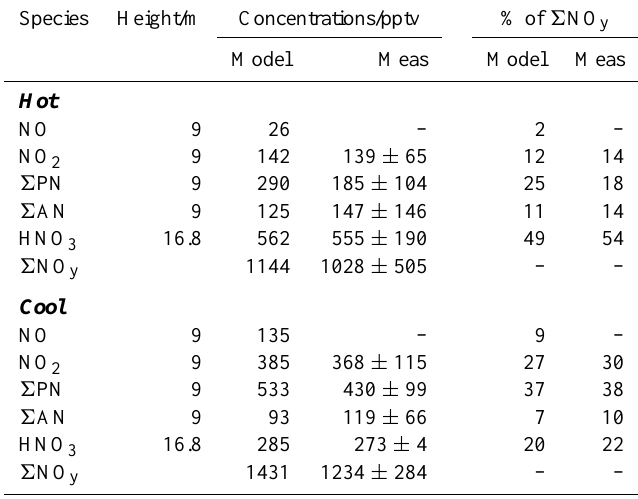
Table 7. Model-measurement comparison of NO y speciation. Model results are taken from the layer closest to the measurement height. Measurements are reported as the mean ± 1 σ . NO was not measured during BEARPEX-2007. 6 NO y represents the sum of all listed NO y components. Species